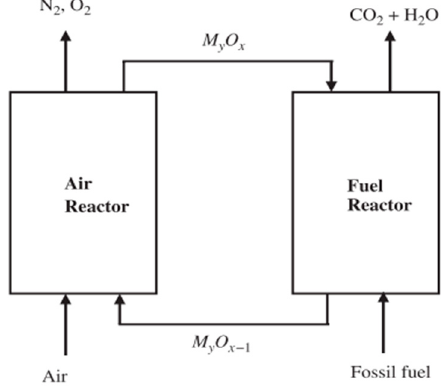
Figure 17. Schematic of the chemical looping combustion process [120].